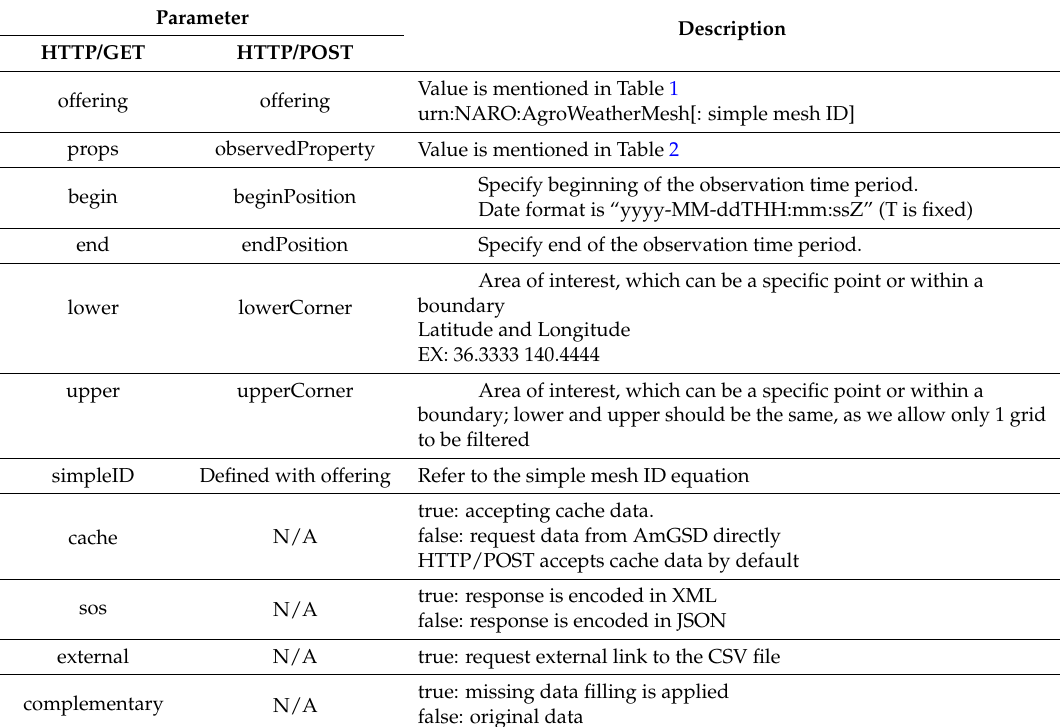
Table 4. Request parameter of the getObservation operation.